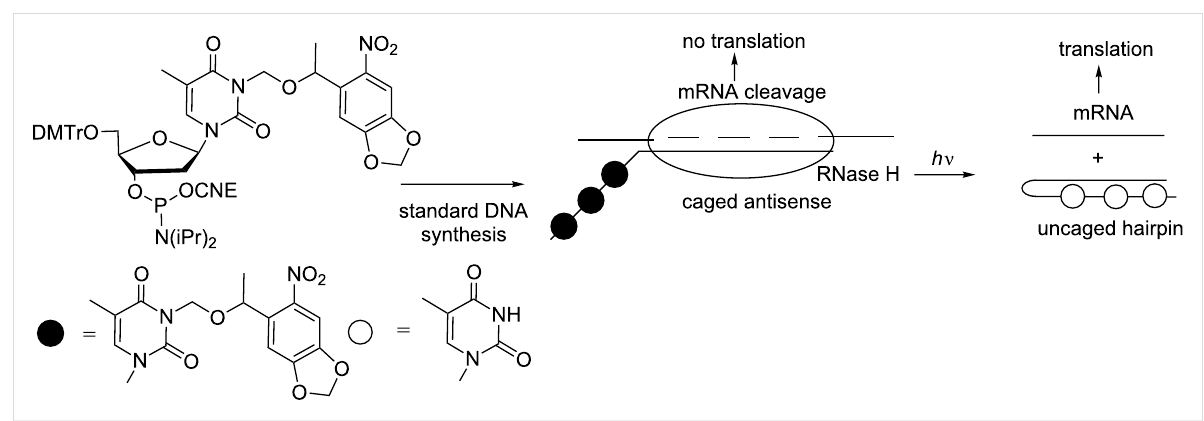
were tested as gene silencing agents to target the reporter gene DsRed in eukaryotic